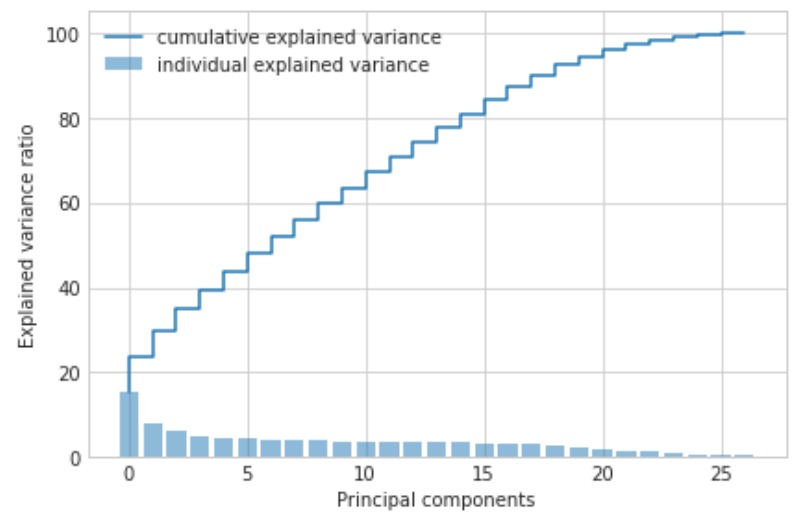
Figure 4. Cumulative explained variance of the dataset.